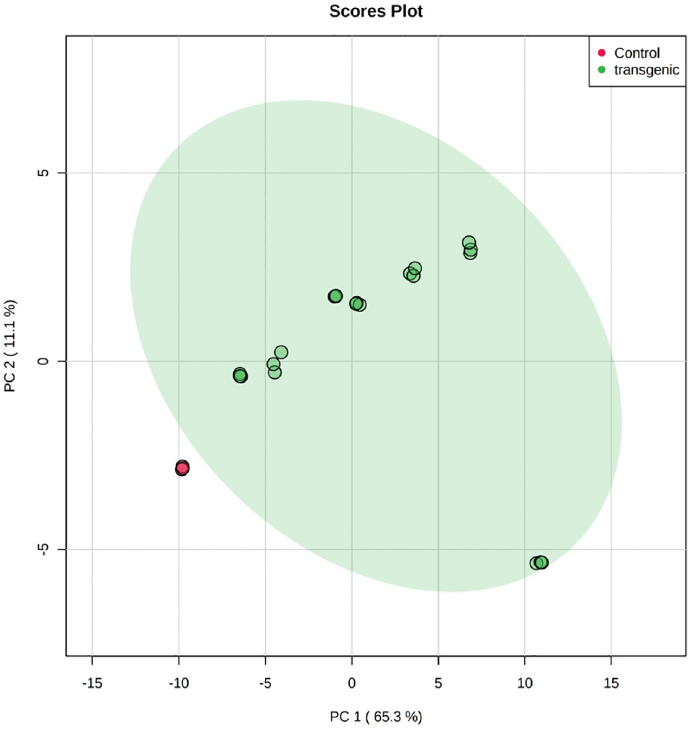
Fig 13. PCA scatter plots of variables showing different metabolites to explain the separation of samples from different lines. PCA score plot of samples from control and transgenic lines. Each with triplicate samples taken for extraction at each time point, were used in the analysis, for a total of 24 data